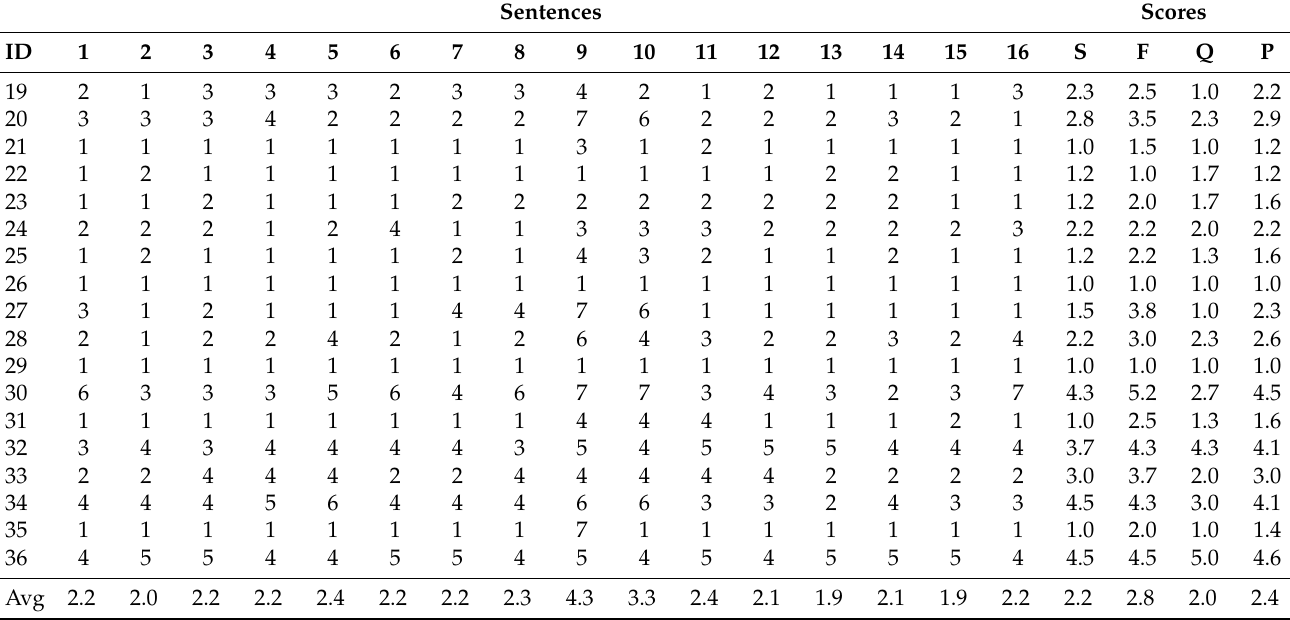
Table A6. PSSUQ results for the Brazilian